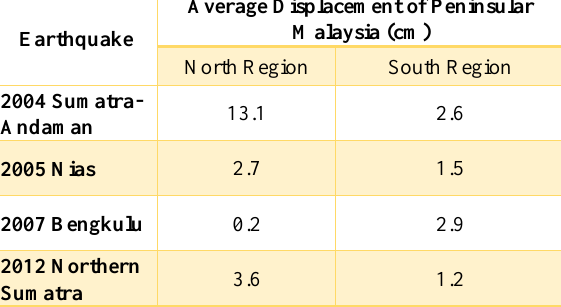
Table 5. Average co-seismic displacements in